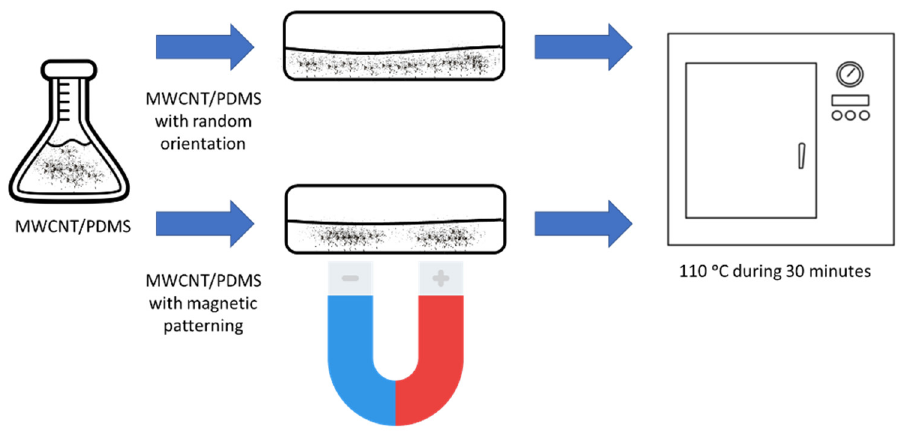
Figure 2. Fabrication process of the composite sensors under magnetic field.